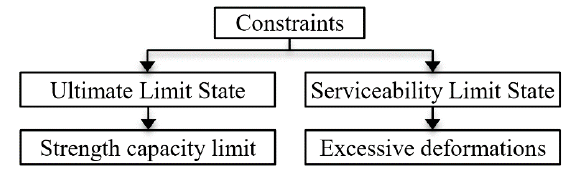
Figure 2. Constraint scheme of the